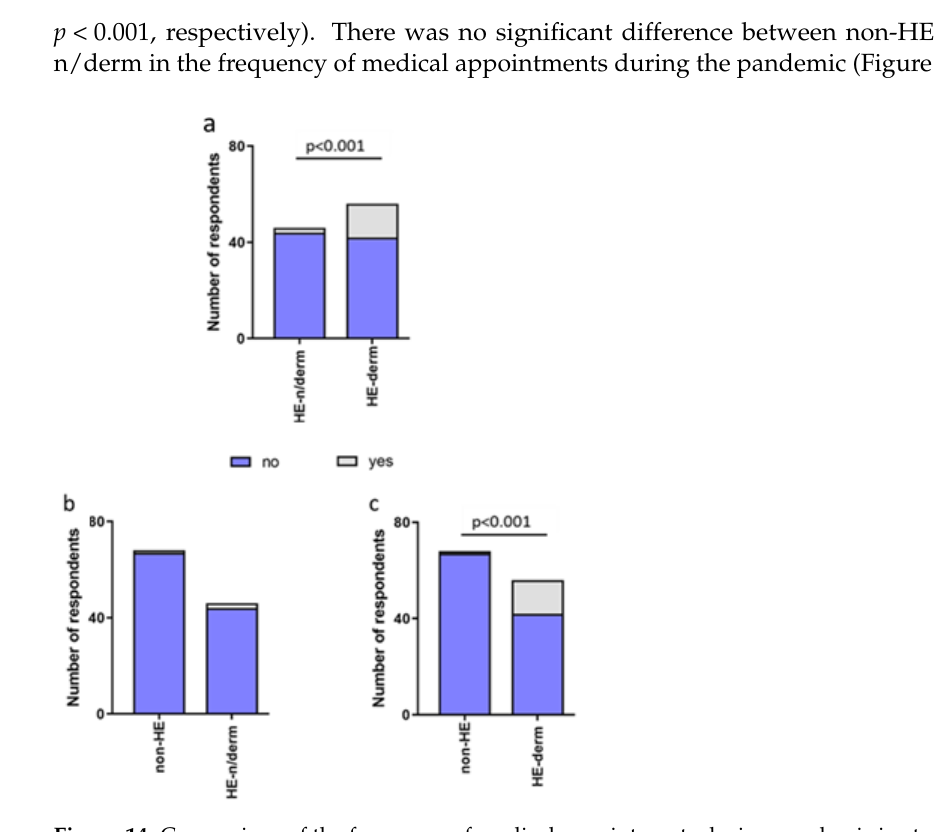
Figure 13. The frequency of medical appointment during pandemic in both groups (HE-study group and non-HE).